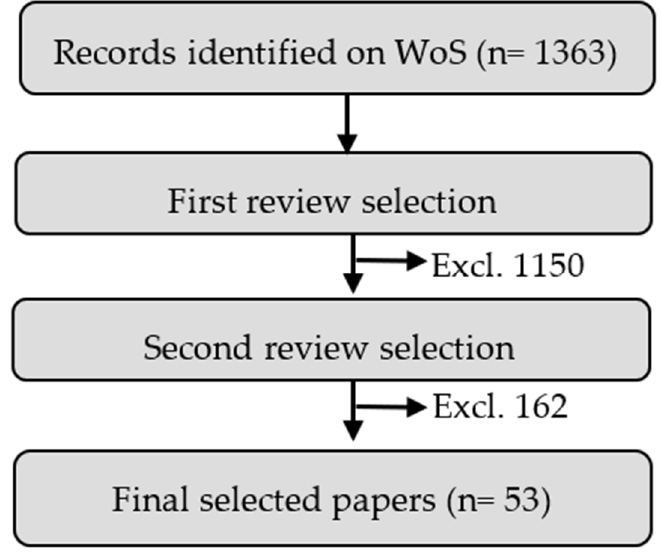
Figure 2. Paper selection steps.